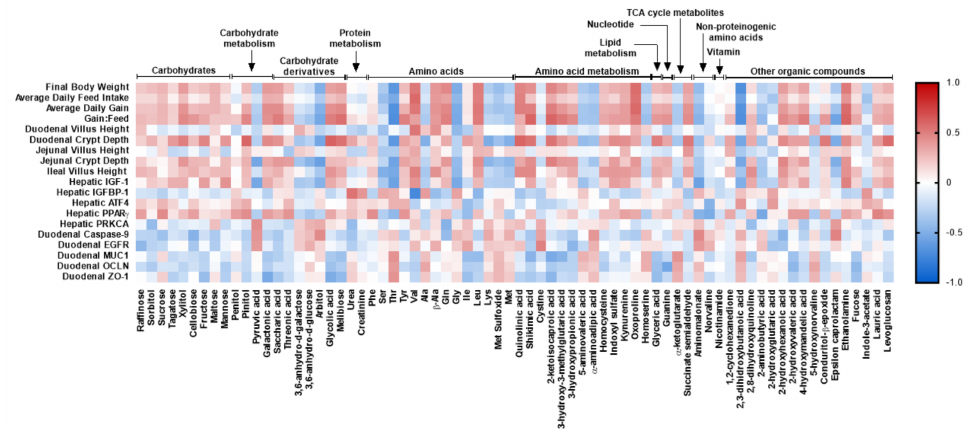
Figure 10. Pearson correlation analysis between significantly changed plasma metabolites, growth performance, gut morphology, and gene expression of markers associated with gut development and hepatic IGF-1 signaling pathway in nursery pigs fed with very-low-protein diets supplemented with Ile, Val, or combination of both. The color of the squares is based on the Pearson coefficient distribution: red represents a positive correlation ( p ≤ 0.05), blue represents a negative correlation ( p ≤ 0.05), and white is indicative of a non-significant correlation ( p > 0.05). IGFBP1 : insulin- like growth factor binding protein 1; ATF4 : activating transcription factor 4; PPAR γ : peroxisome proliferator-activated receptor gamma; PRKCA : protein kinase C alpha; EGFR : epidermal growth factor receptor; MUC1 : mucin 1; OCLN : occludin; ZO1 : zonula occludens 1. n =